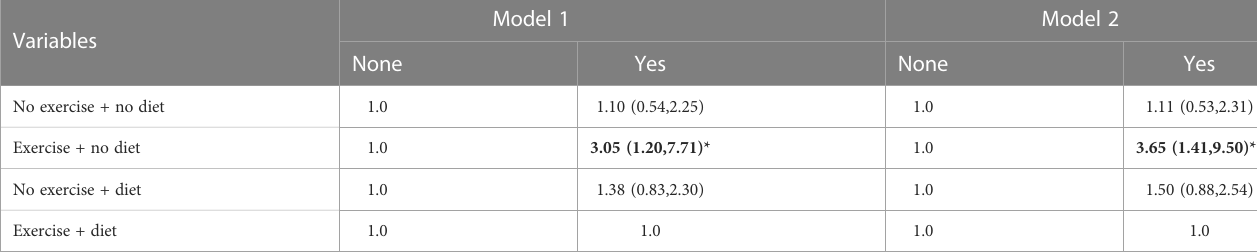
TABLE 12 The correlation between intervene and cardiovascular diseases.